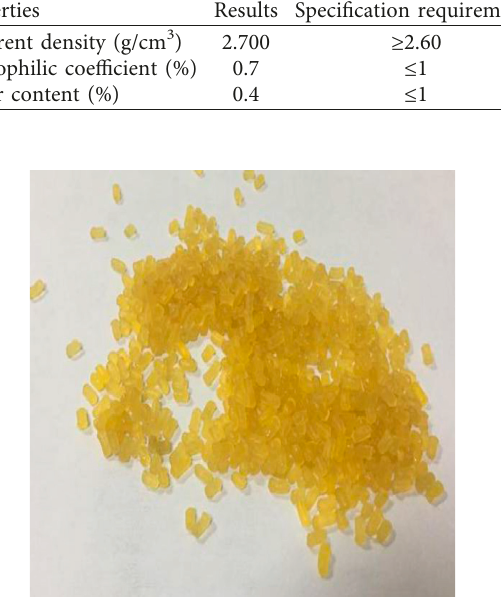
Figure 1: High-viscosity agent